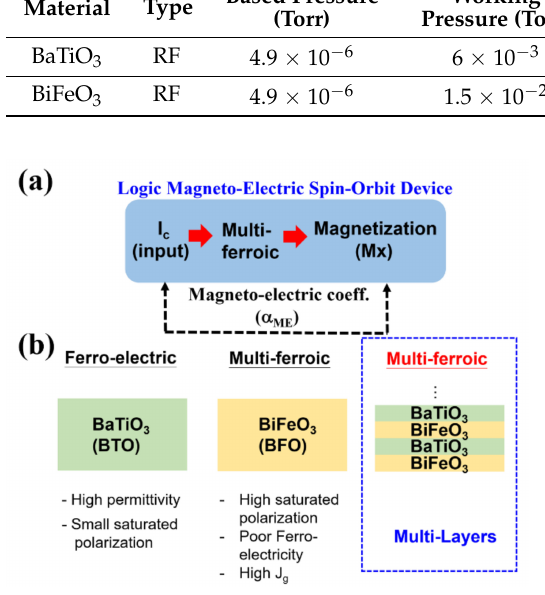
Table 1. The process parameters for our deposition of BaTiO 3 and BiFeO 3 films. Material